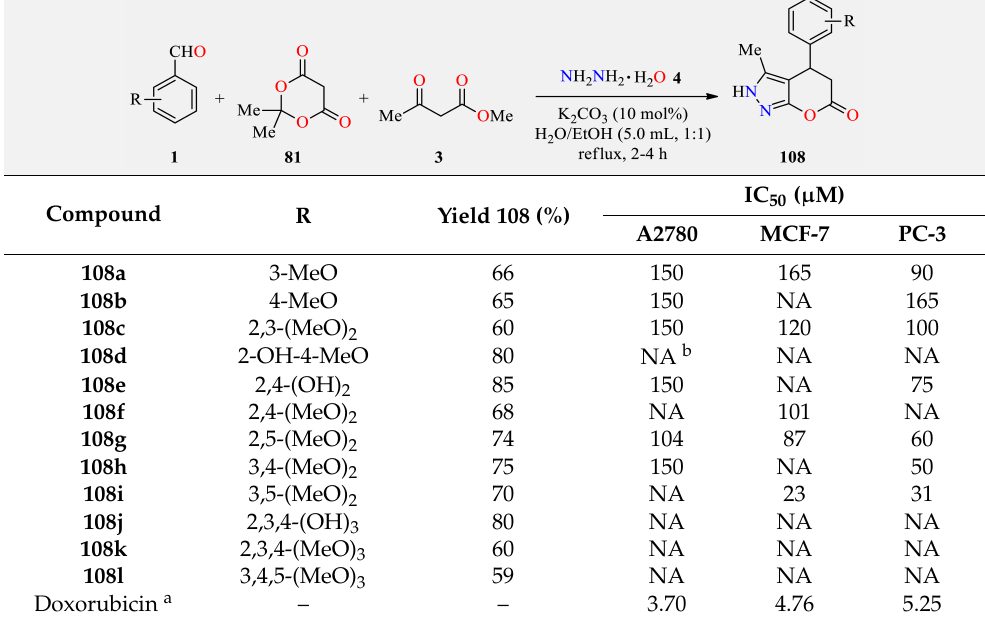
Table 31. Four-component synthesis and in vitro anticancer activity of 4,5-dihydropyrano[2,3- c ]pyrazol-6(2 H )-one derivatives 108